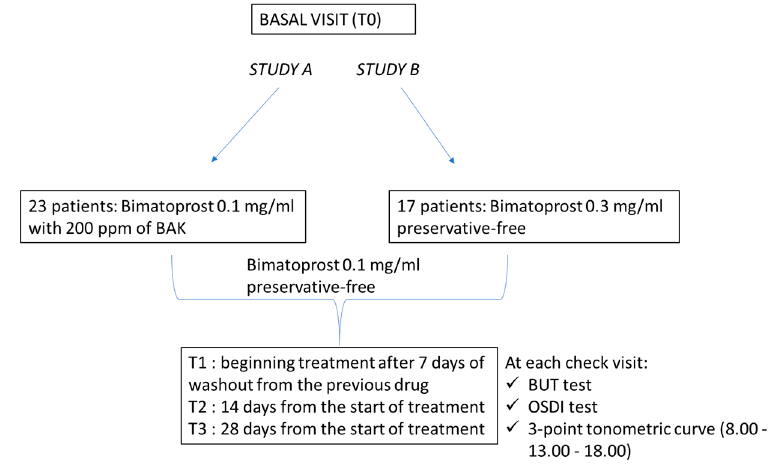
Figure 1. Flow chart of the study.